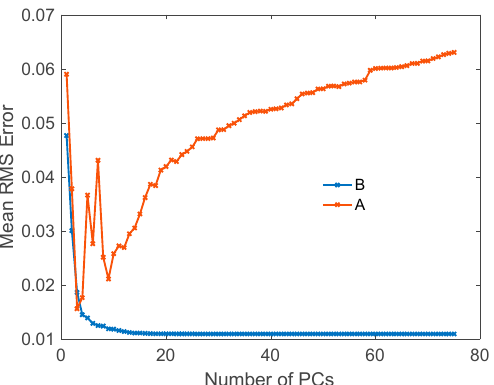
Figure 4. The mean RMS errors of the simulated BRDFs using previous principal component analysis (PCA) regression method ( A ) and our HSBR model ( B ), respectively.